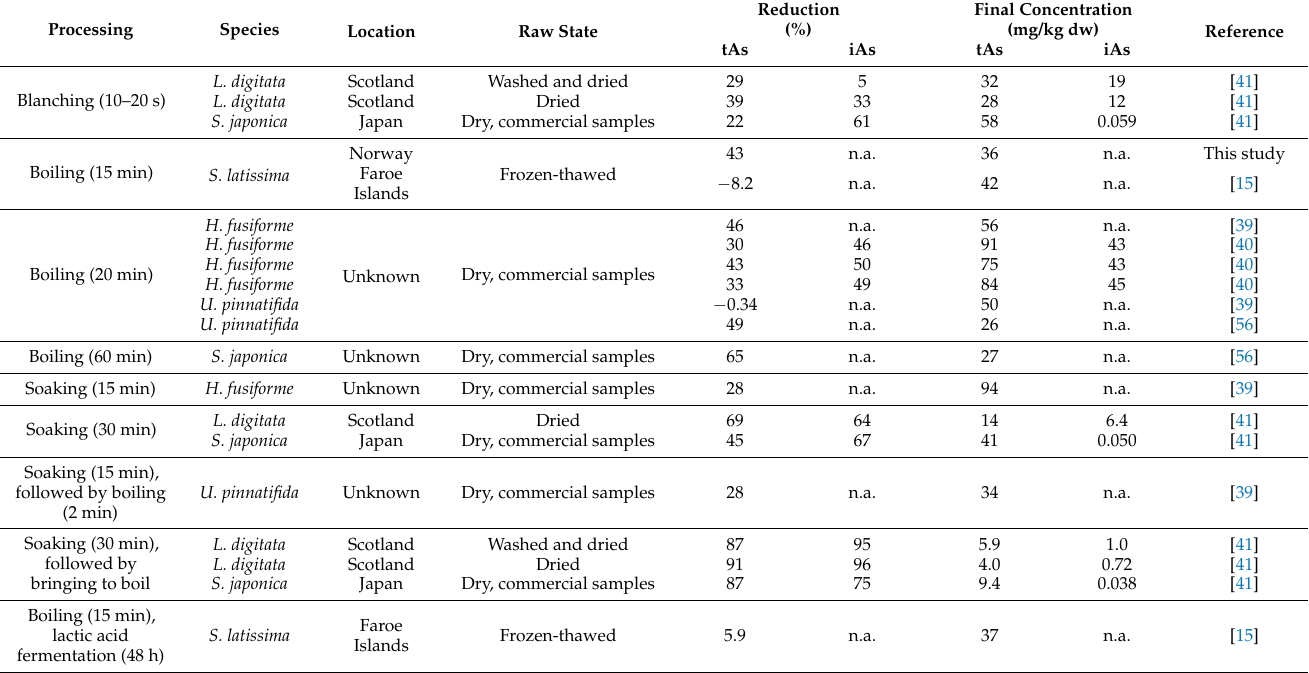
Table 5. Reduction in total (tAs) and inorganic (iAs) arsenic during processing of brown